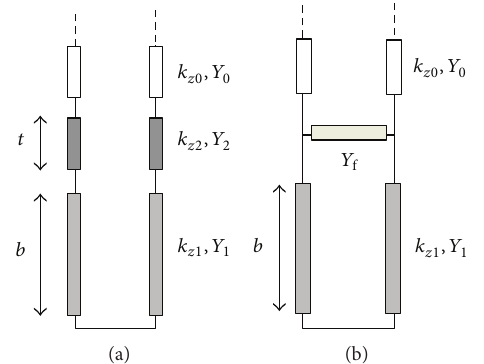
Figure 2: Transverse equivalent network of the structure in Figure 1. Exact representation (a) and approximate representation (b) valid for a high-permittivity thin-film